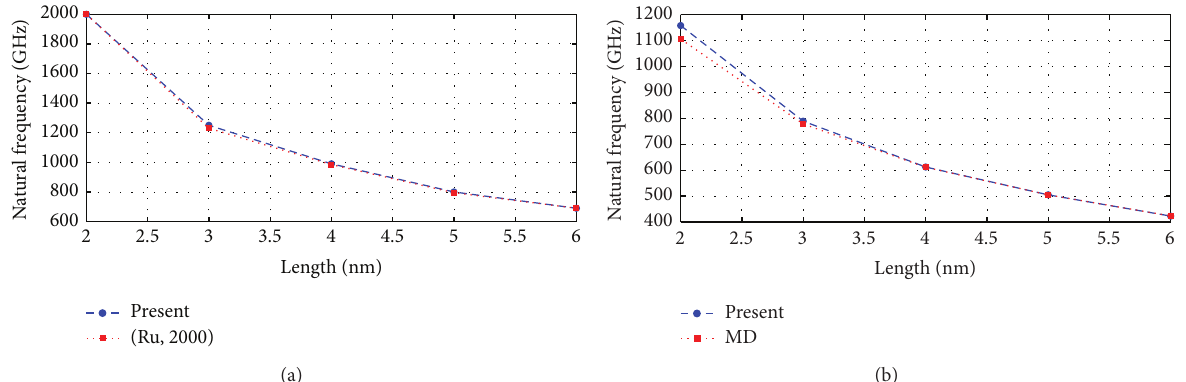
Figure 5: Comparison of the obtained natural frequency using BEAM4 and BEAM188 elements with the results of MD simulations and [10] (apex angle = 38.9 ∘ ).